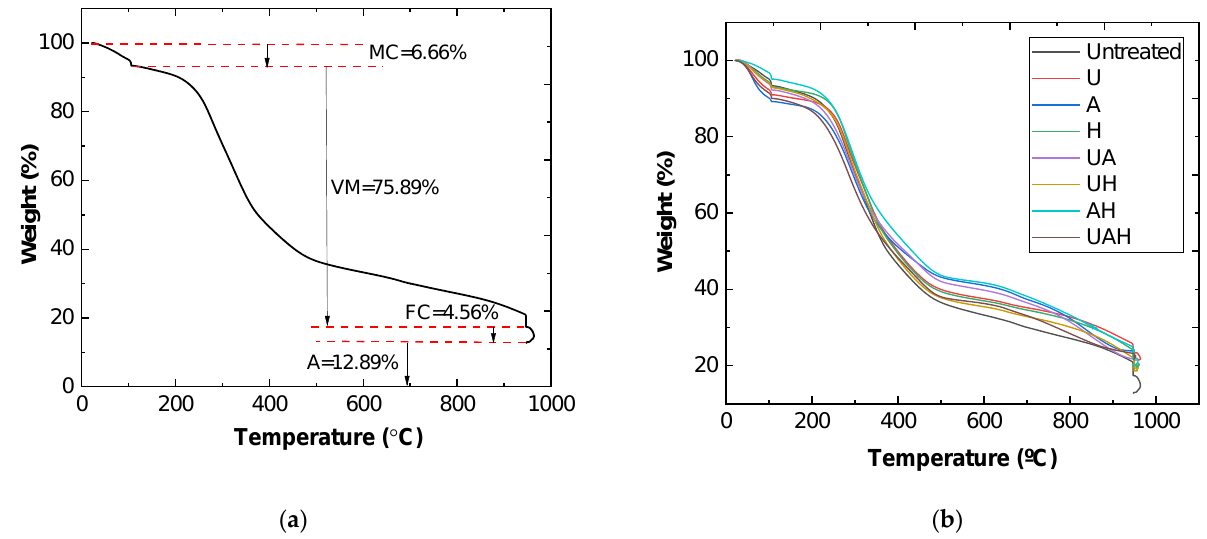
Figure 4. TGA graphs of ( a ) untreated sludge with proximate parameters shown, and ( b ) sludge before and after all pre- treatments.